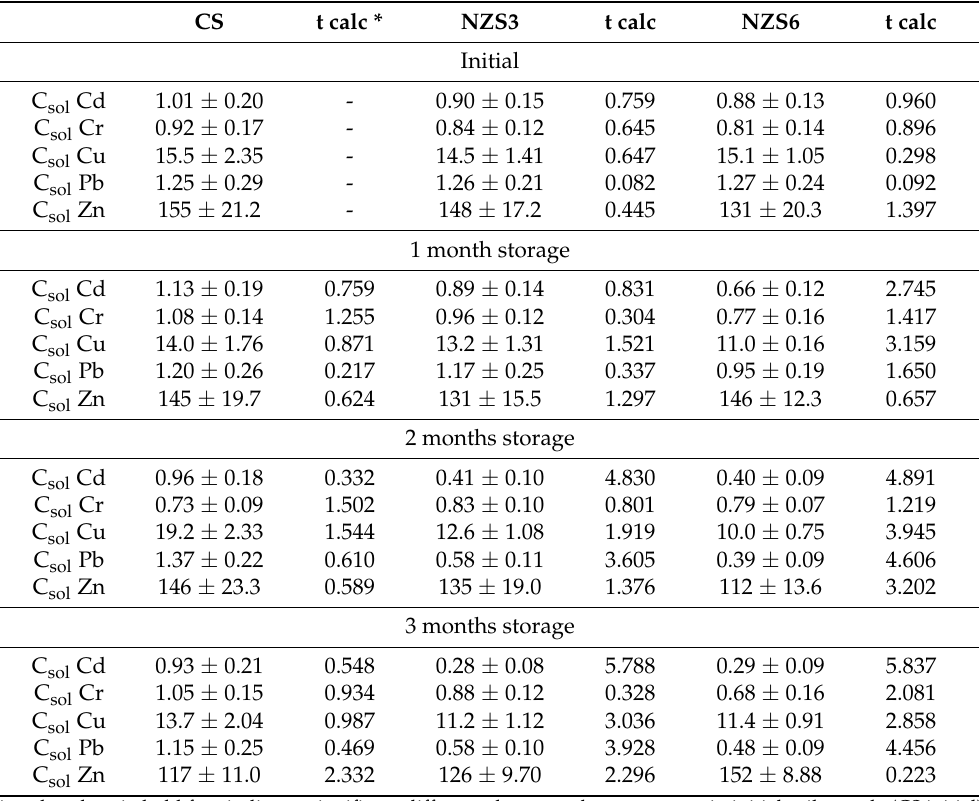
Table 3. DGT-measured concentrations (C DGT ) of heavy metals ( µ g L − 1 ) in soil slurries of control soil (CS) and mixtures with zeolite (NZS3 and NZS6) during the three-month storage (average ± standard deviation, n = 3 parallel